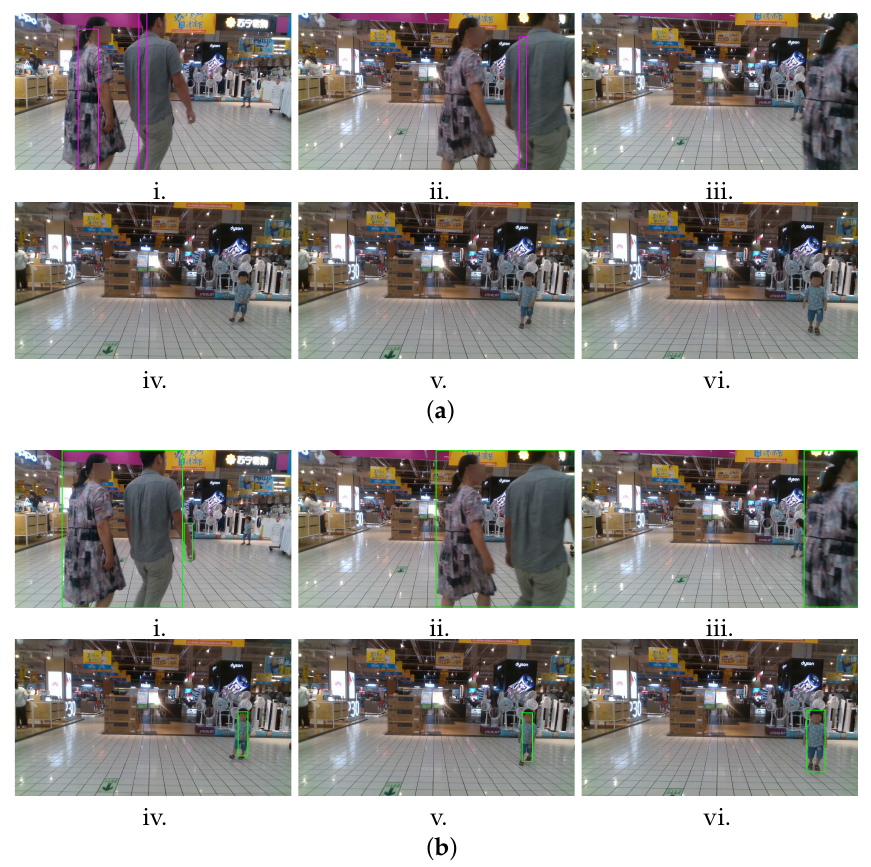
Figure 22. Comparison of the proposed method with VbOAD [28] algorithm on the market se- quence of Open LORIS-Scene data set [29] with multiple dynamic obstacles of different sizes. ( a ) ( i – vi ) Time-sampled snapshots with the output of VbOAD. ( b ) ( i – vi ) Time-sampled snapshots with the output of our proposed